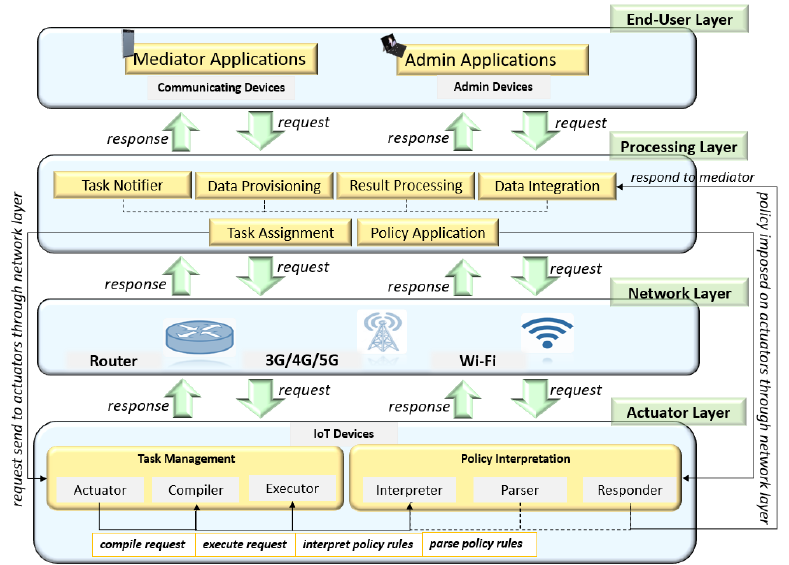
Figure 1. Reference architecture represents devices: communicating devices, admin devices, and IoT